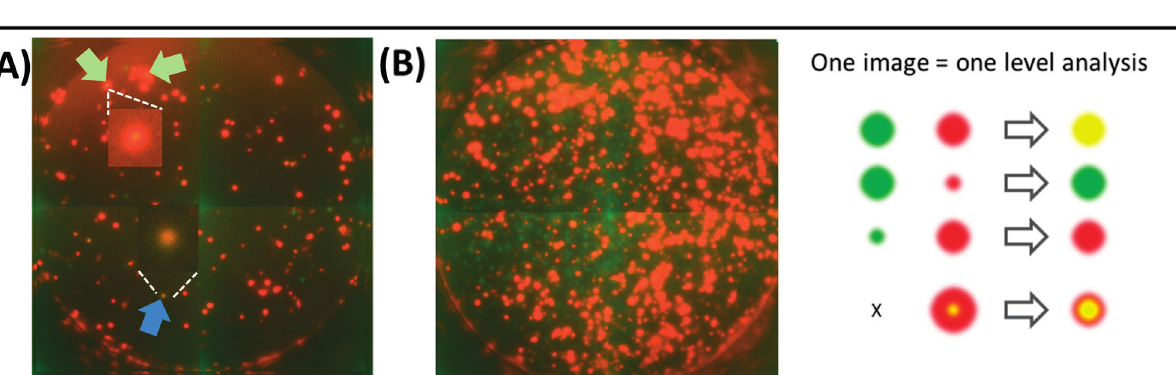
Figure 2. Challenges of broadband filter analysis of FluoroSpot plates. PBMC were stimulated with the CEF peptide pool ( A ) or anti-CD3 ( B ) and tested simultaneously for IFN ɣ and IL-2 secretion using FITC (for IFN ɣ ) and Cy3 (for IL-2) fluorophores. Images were taken with a Zeiss reader utilizing a dual band filter for FITC and Rhodamine. FITC signals are weak and small, while Cy3 signals are strong and larger, overlaying smaller FITC spots ( B ), leading to false low counts for green spots. In panel ( A ), the blue arrow points to a yellow spot that is likely to be caused by dual secretion of cytokine by one cell (see insert for close up). Similar yellow signals can also be found in the center of larger, high intensity red spots (green arrows), leading to false high dual spot counts (see insert for close-up). The challenges of such one level FluoroSpot analysis are illustrated on the right.